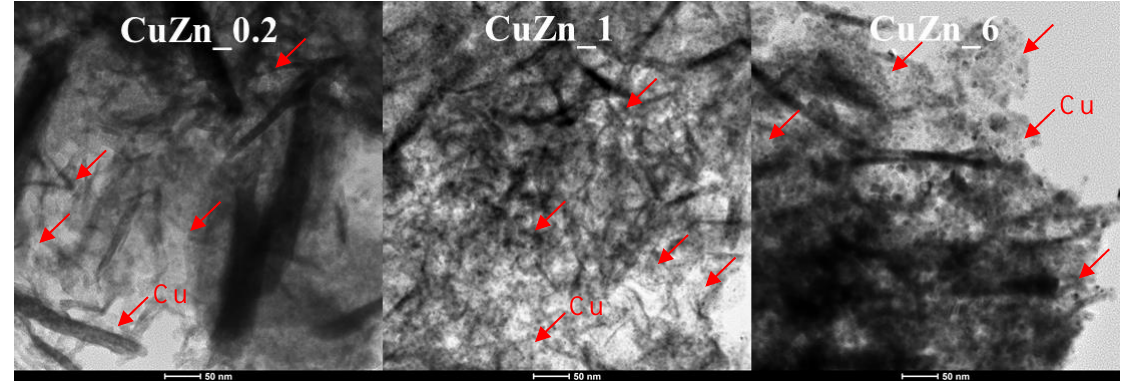
Figure 5. TEM micrographs for CuZn_0.2, CuZn_1 and CuZn_6. (Scale bar: 50 nm).